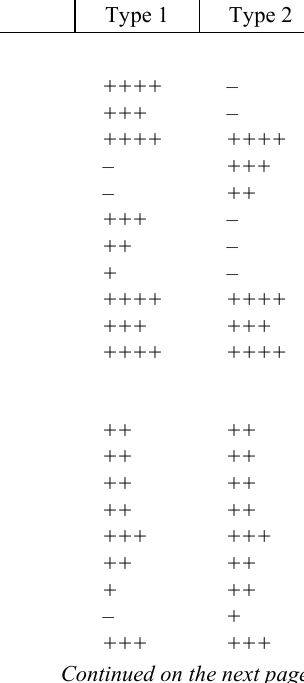
Table 2. List of taxa discerned in the collections of the authors (+ rare, ++ uncommon, +++ frequent, ++++ common) Table 2.